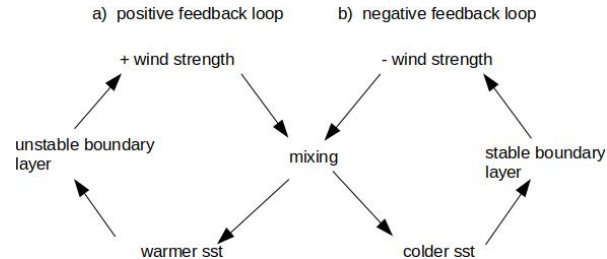
Figure 4. Side (a) of the figure shows a positive winter feedback loop, and side (b) shows a negative summer short-circuit. Drawn after Gröger et al.